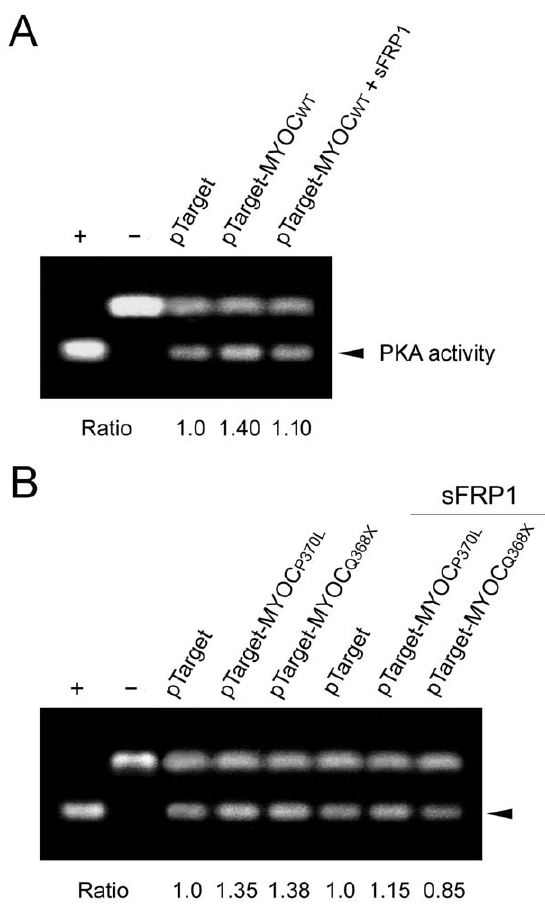
Figure 5. Effects of sFRP1 on PKA activity in TM cells. A . Cells were transfected with pTarget and pTarget-myocilin WT (pTarget- MYOC WT ) for 48 h. One set of samples was treated overnight with sFRP1 and the other was untreated. Lysates collected were subjected to PKA assay as described in Fig. 2B. B . Cells transfected with pTarget, pTarget-myocilin P370L (pTarget-MYOC P370L ) and pTarget-myocilin Q368X (pTarget-MYOC Q368X ) were untreated or treated overnight with sFRP1. Lysates were subjected to PKA assays. The PKA activity (arrowhead) was determined by densitometric analyses. Results were expressed as ratios relative to the pTarget control. Experiments were repeated 3 times. Data from one representative experiment are presented.